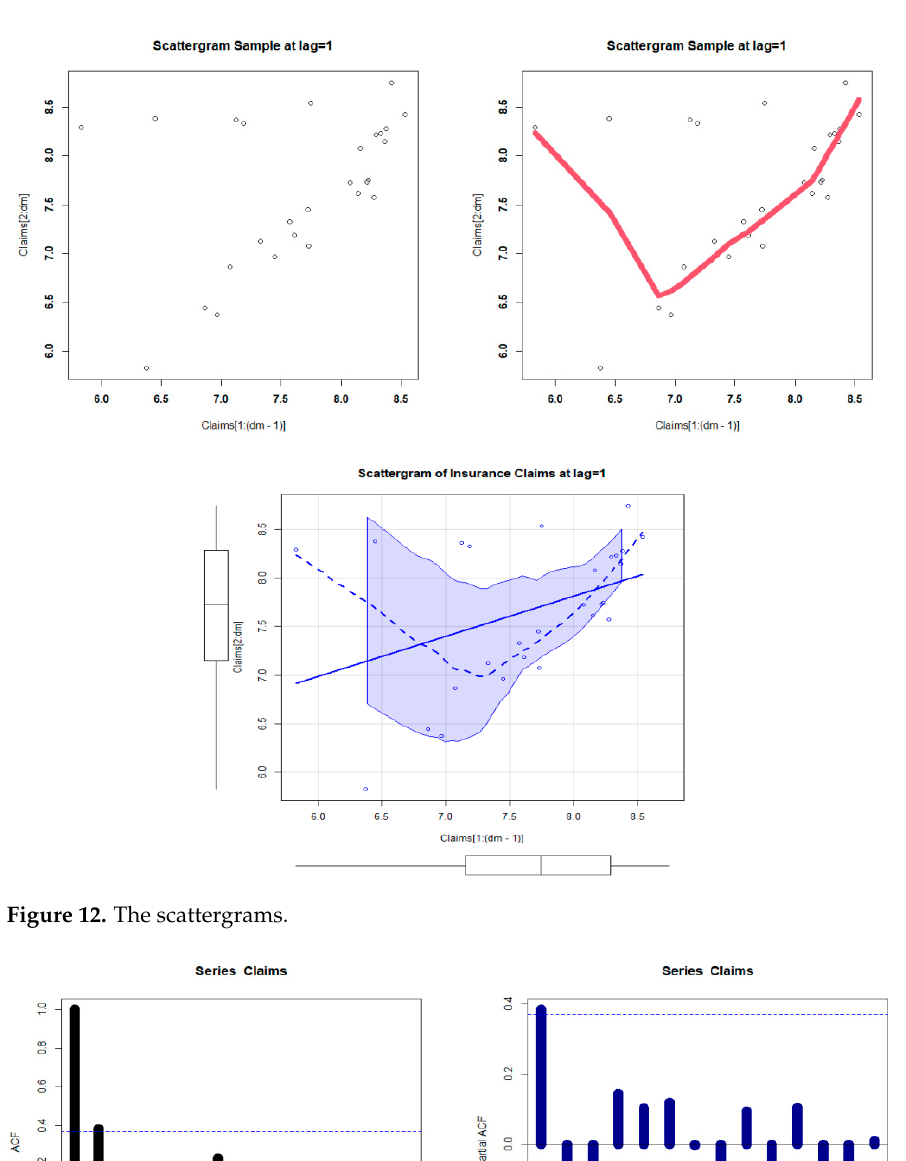
Figure 13. The ACF (left) and the partial ACF (right) for the insurance claims data.